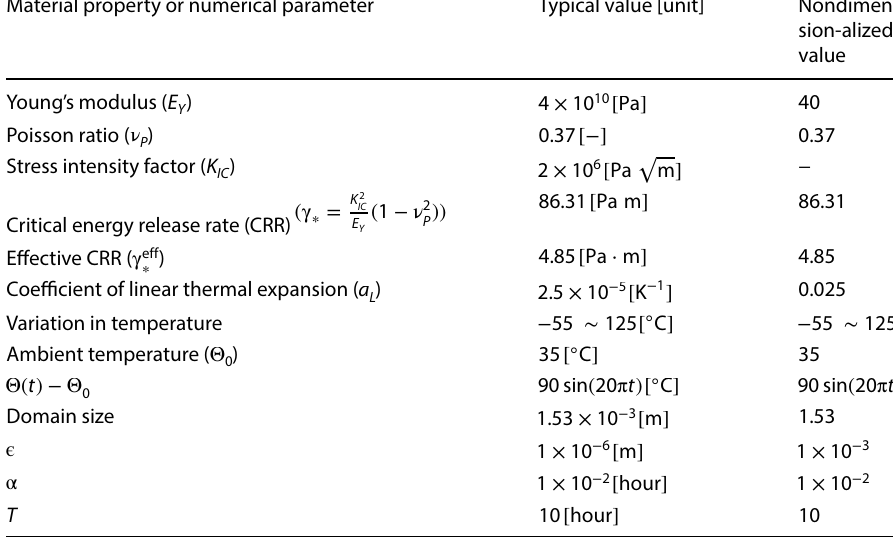
Material property or numerical